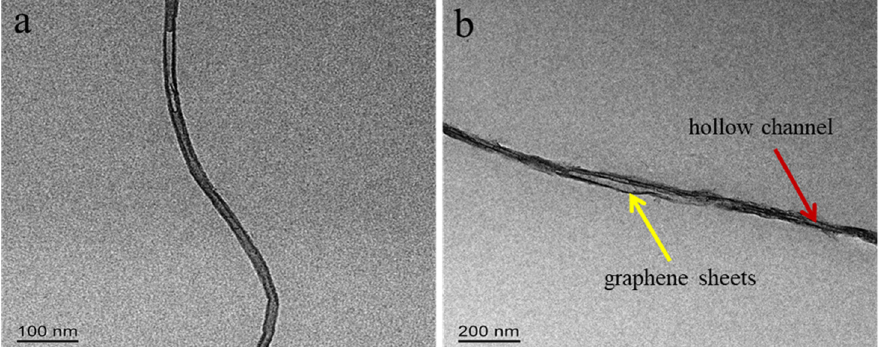
Figure 1. TEM images of ( a ) raw MWCNTs and ( b )